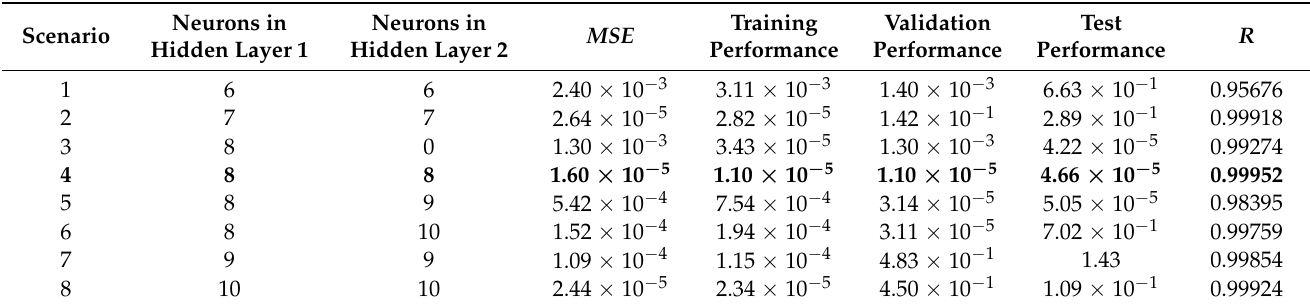
Table 3. ANN architectures and their performance for a network with three inputs.